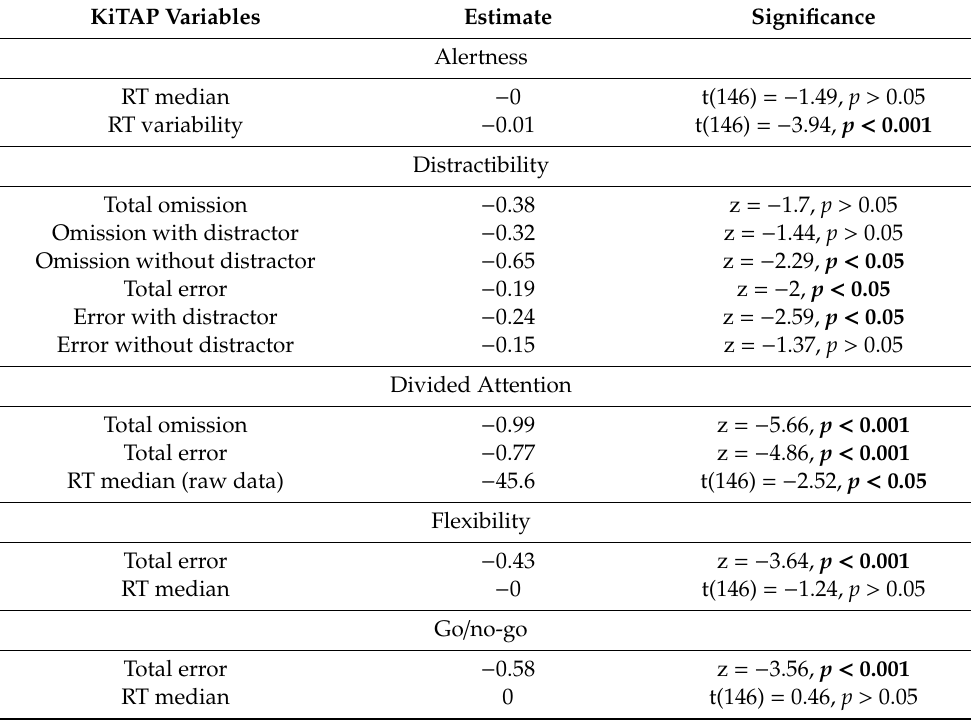
Table 4. Contrasting non-medicated group with the mean of the other two